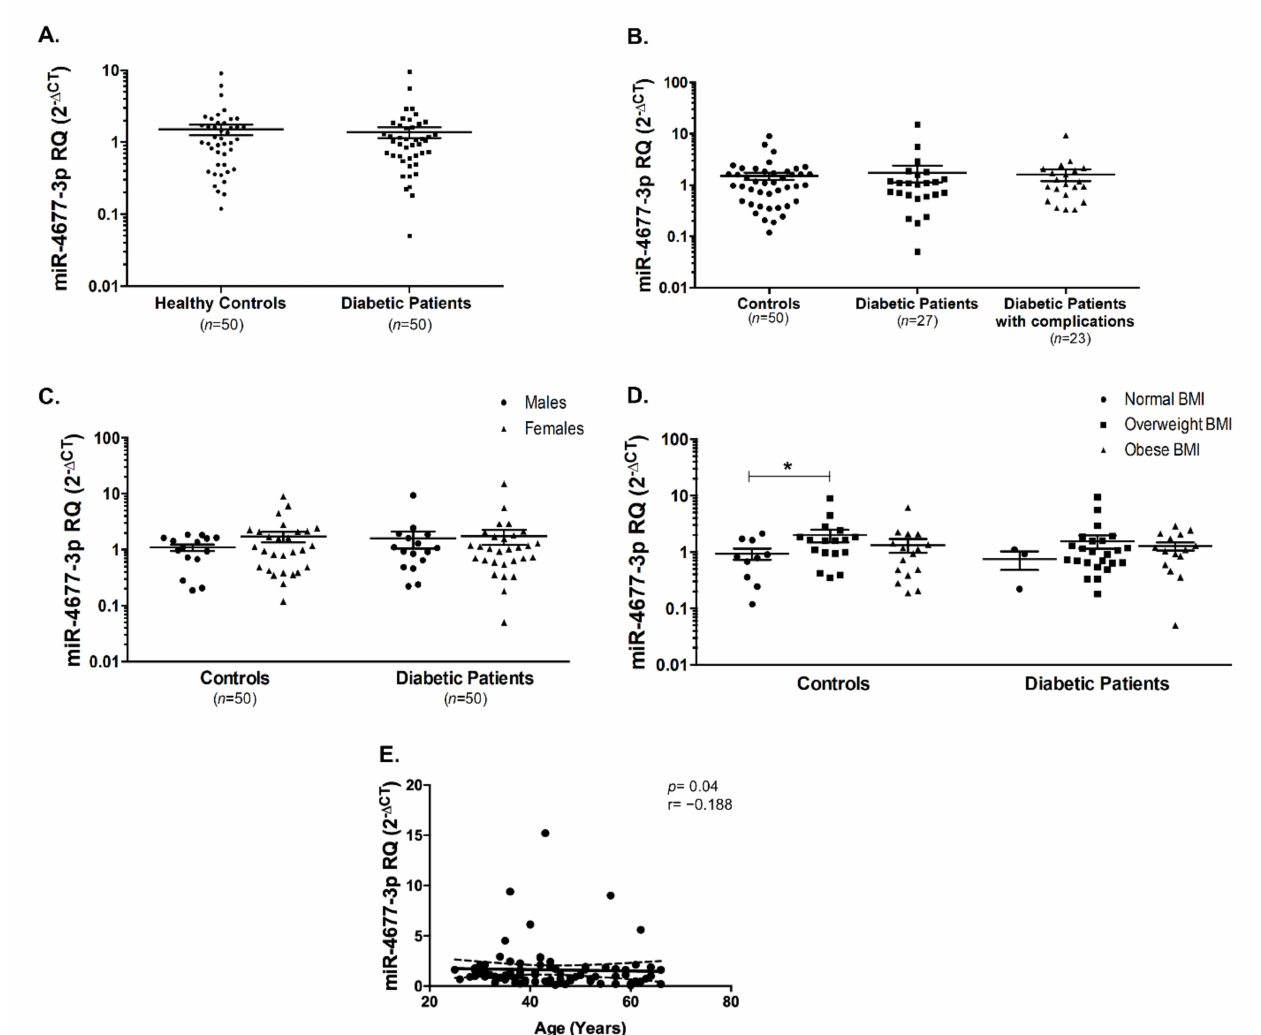
Figure 5. miR-4677-3p was unaltered in T2DM patients compared to healthy controls. ( A ) miR-4677-3p was not changed in all T2DM patients as well as ( B ) in diabetic patients with or without diabetic complications. ( C ) miR-4677-3p levels were unaltered by gender in healthy controls and diabetic patients. ( D ) miR-4677-3p was elevated in healthy overweight individuals compared to healthy individuals with normal BMI. ( E ) There was a negative correlation between miR-4677-3p and age. Dashed lines represent 95% confidence intervals. * indicates p <